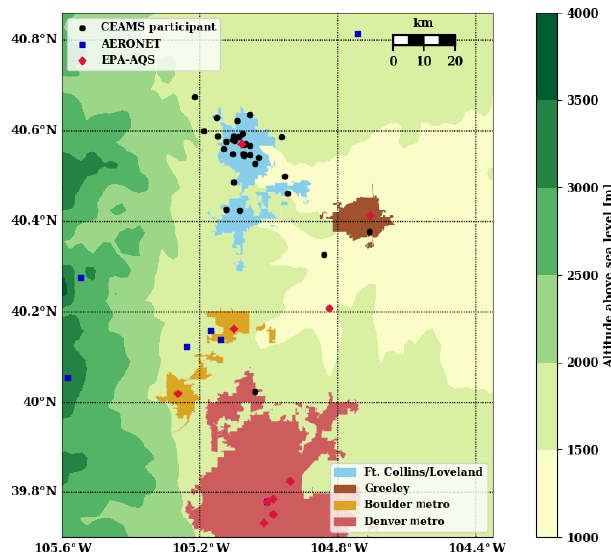
Figure 1. Map of northern Colorado, with CEAMS participant lo- cations (black), AERONET sites (blue), and EPA-AQS sites (red). Map also shows topography (Amante and Eakins, 2009) and ma- jor cities and metropolitan areas (using cartographic boundary files from 2015 TIGER/Line Shapefiles,